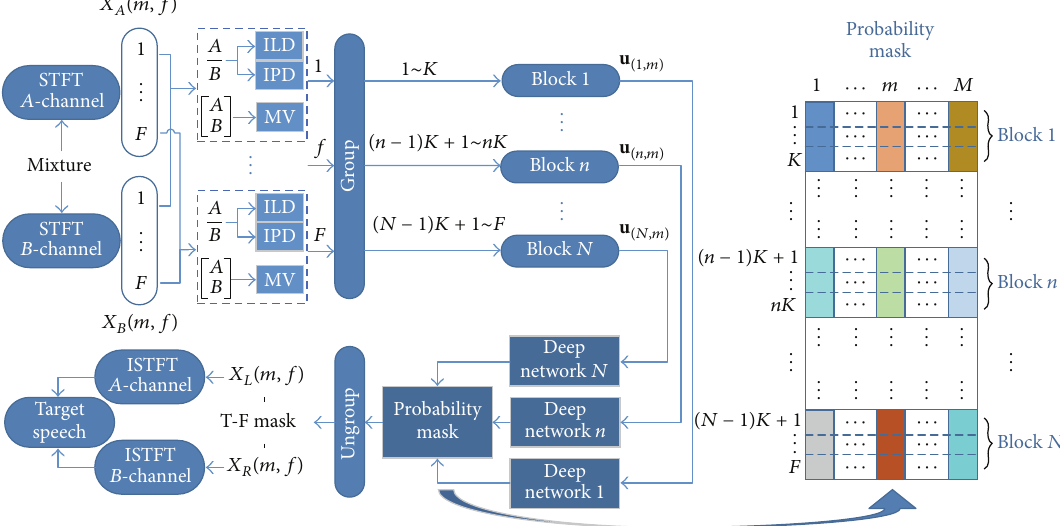
Figure 5: The architecture of the proposed system using deep neural network based time-frequency masking for blind source separation.